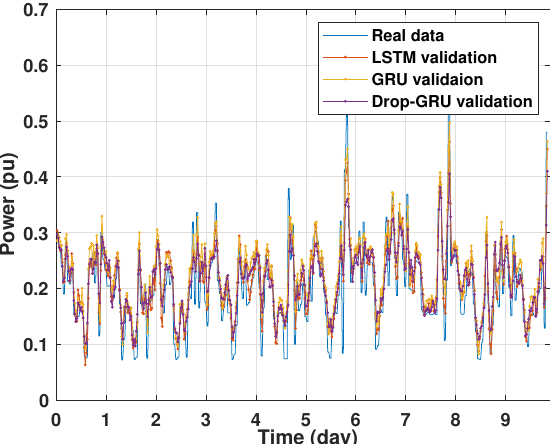
Figure 9. Training and validation for 1 day forecasting.